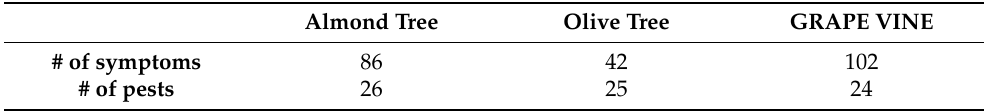
Table 5. Summary of the dataset